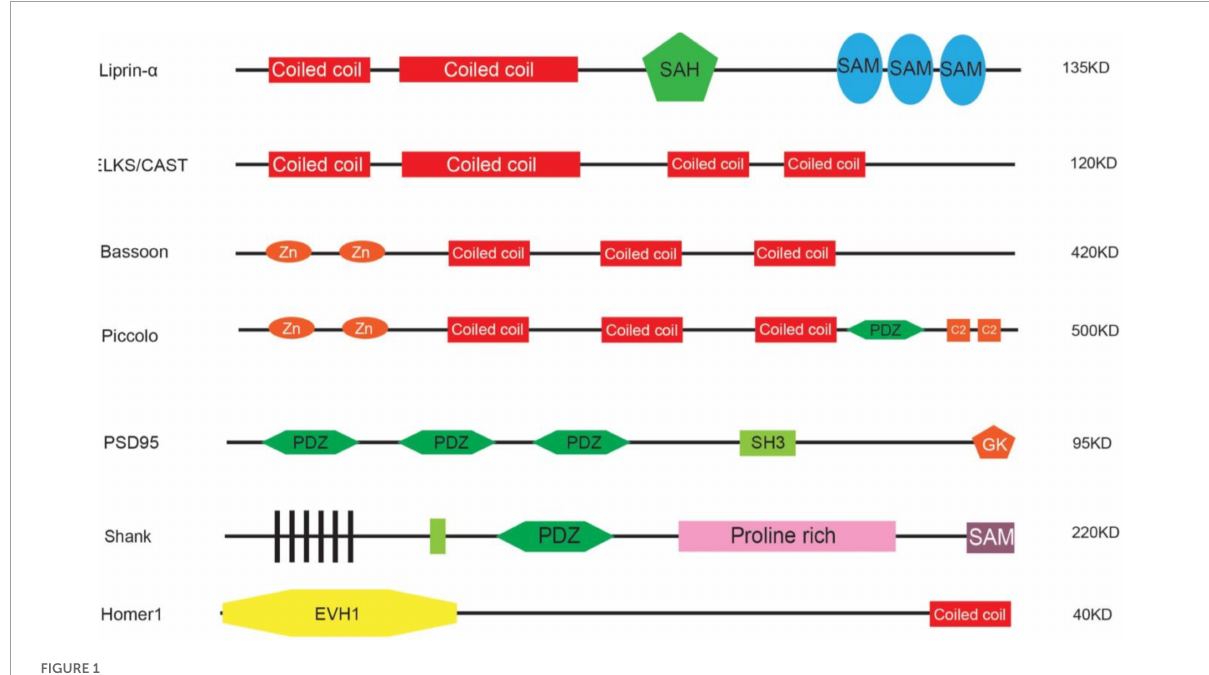
FIGURE1 Schematic illustration of representative scaffold proteins (not